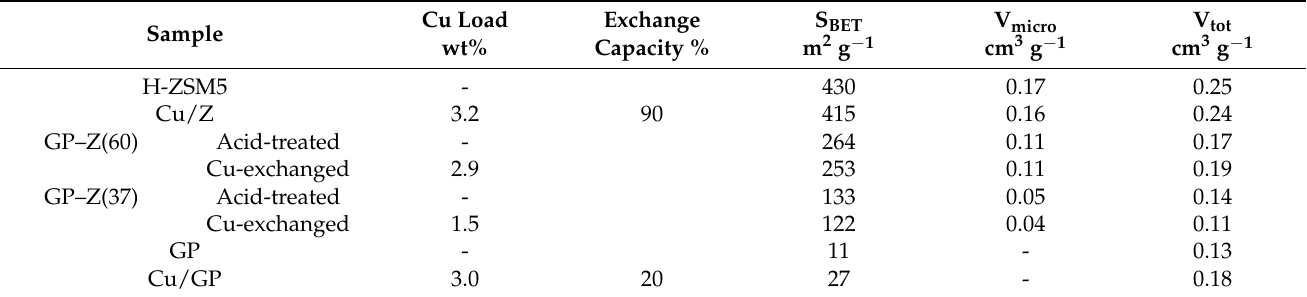
(CEC = 0.62 mmol/g for bivalent copper cation), evaluated on the basis of the actual Si/Al ratio in the zeolite. Table 1. Copper content (by ICP–MS), fractional cation exchange capacity, BET specific surface area, micropore and total pore volumes for Cu-exchanged composite monoliths and their acid-treated precursors compared with pure Cu/GP and Cu/Z